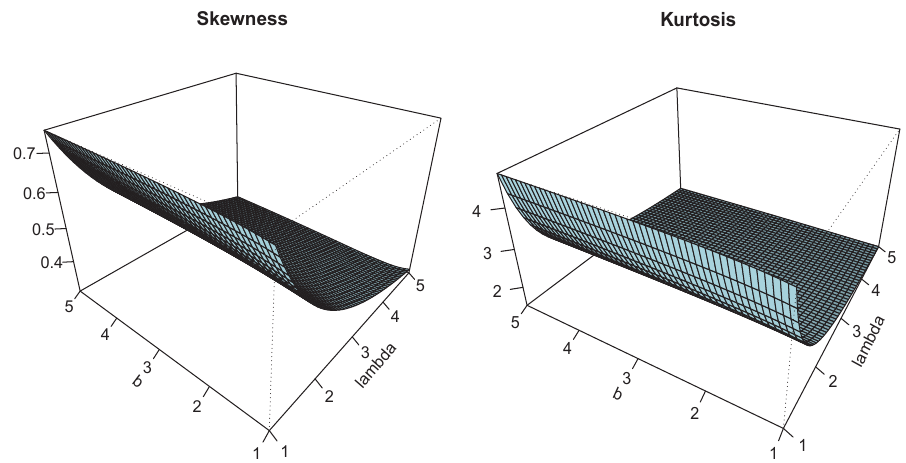
Figure 7. Plots of γ ∗